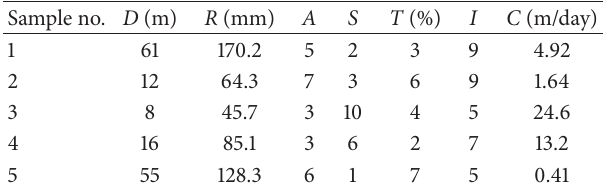
Table 9: Factor values of the samples in the case study.